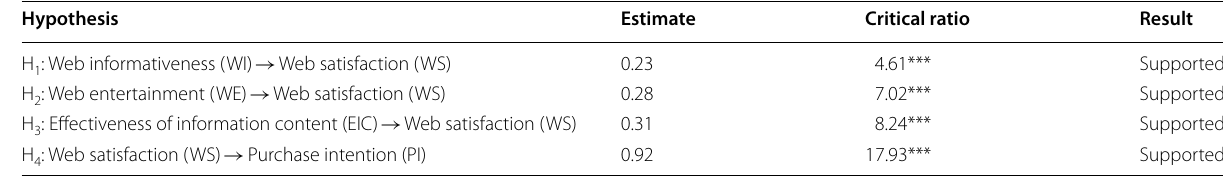
Goodness of fit ratio: CMIN/df